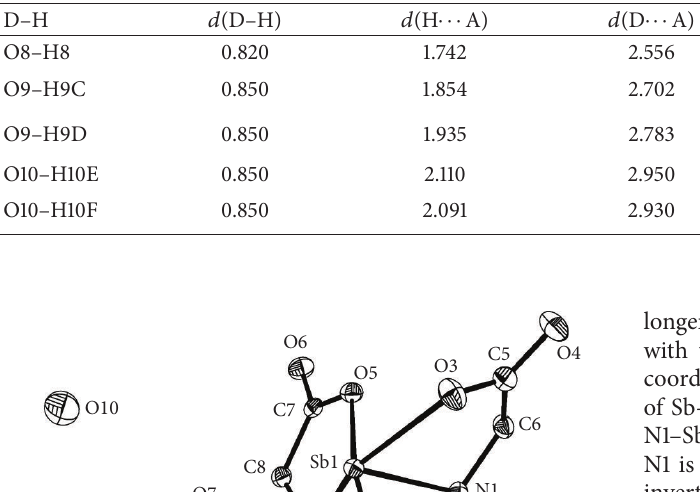
Table 3: Hydrogen bond lengths (˚A) and bond angles ( ∘ ) for the title complex.